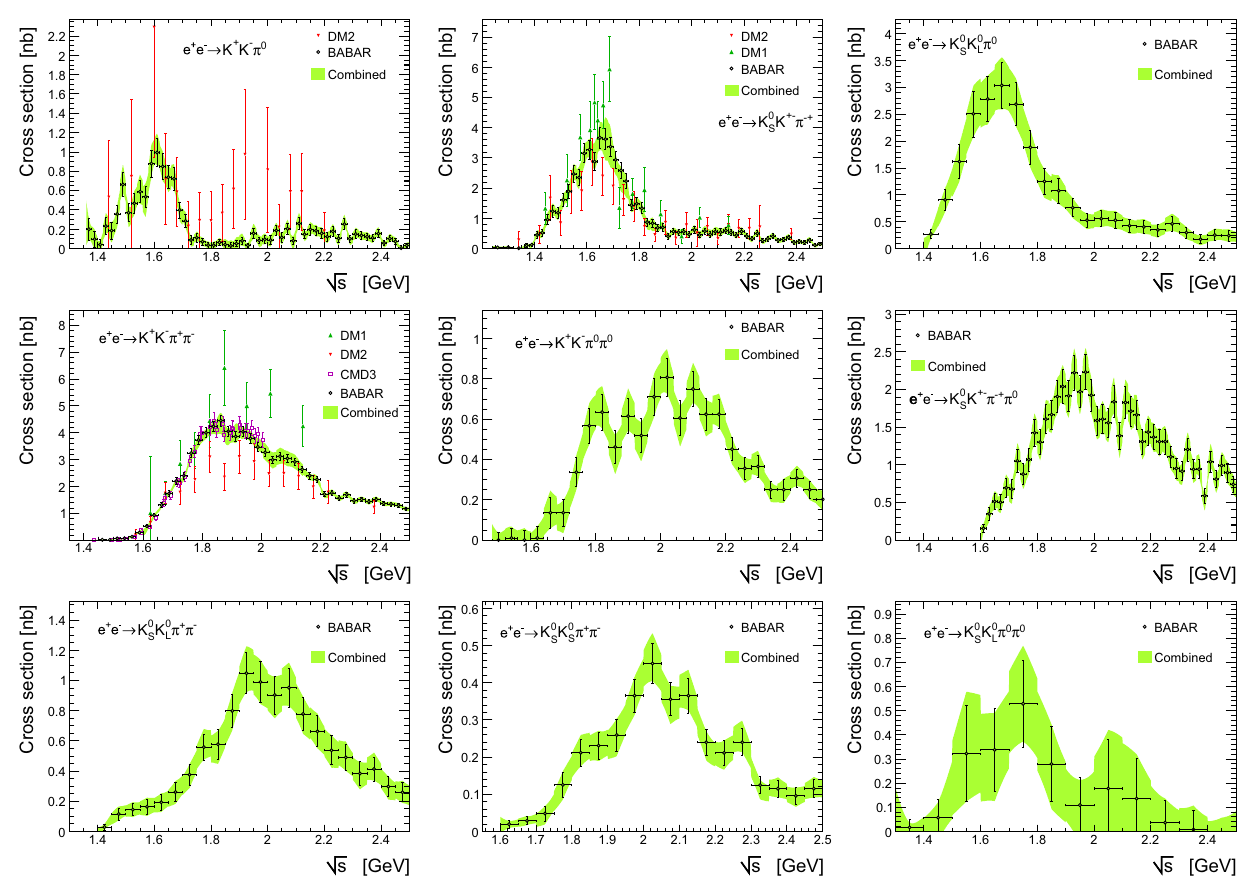
Fig. 7 Barecross-sectiondatafor K K π ( toprow )and K K ππ ( middle and bottom rows ) final states. See text for references. The error bars of the data points include statistical and systematic uncertainties added in quadrature. The green bands show the HVPTools interpolations within 1 σ uncertainties. Because the integral of the interpolation within a bin